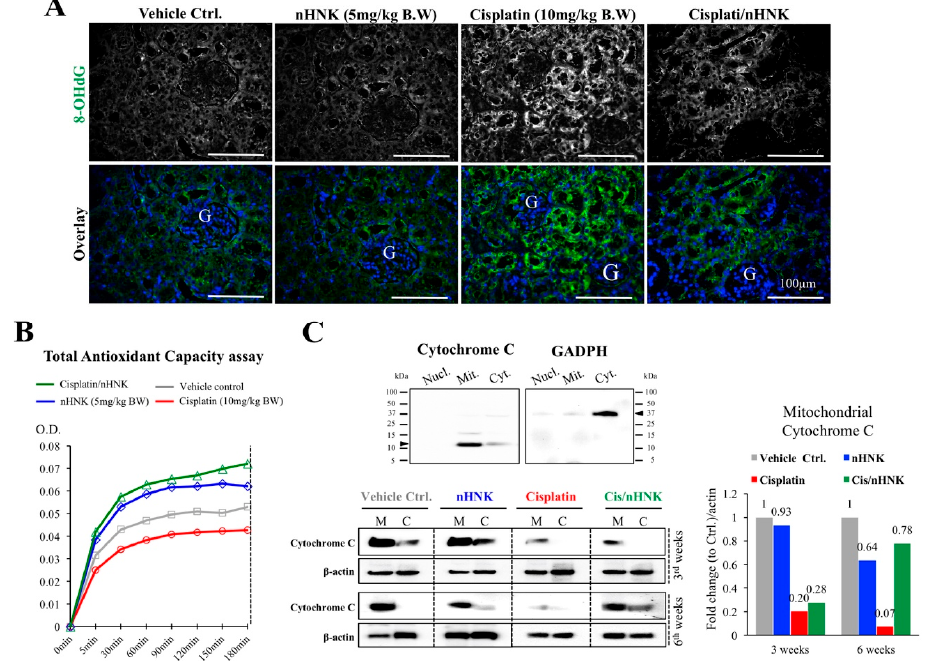
Figure 4. Oxidative stress assessments on the reduction of oxidative damages and improved antioxidant capacity in nHNK-treated animals. ( A ) Paraffin-embedded kidney sections were used, and oxidative stress was assessed with marker protein 8-hydroxyguanosine. Control and nHNK groups showed minimal amounts of 8-OHdG, an intense signal can be detected in the cisplatin-injured animals, and signal intensity was decreased in the treatment group. ( B ) To assess the antioxidant capacity of the kidney, total antioxidant capacity (TAC) assay was carried out. Cisplatin-injured kidney showed the lowest total mitochondria enzyme activity as assessed by TAC assay (red line). Groups in the presence of nHNK (blue and green lines) showed the highest two recording optical density values, which indicated that more active mitochondria enzymes were available in these groups, which suggested that nHNK maintained and facilitated the antioxidation property of the kidney. ( C ) Western-blotting analysis showed the majority of the cytochrome c protein appeared in the mitochondria fraction (M) of control, nHNK alone and the treatment groups with minimal detection in the cytosolic fraction (C). However, a significant reduction of total cytochrome c protein expression in the mitochondria fraction was observed in cisplatin-injured